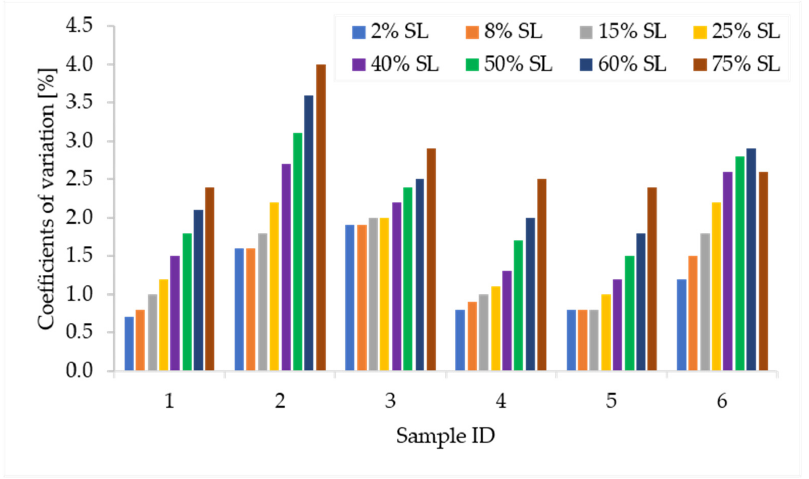
Figure 4. Coefficients of variation of fibrogram length values among tests at each percent span length during the short-term study. An increase in CV% from the longer span lengths (lower percentages) to the shorter span lengths (higher percentages) could be due to a decrease in the signal-to-noise ratio of the sensor. The greatest occlusion of light occurs at the base of the beard, which means very little light, i.e., signal, reaches the sensors, thereby allowing electrical noise to have a greater influence on the output. As it was reported, the length measurement variations of the fibrogram at each span length for the short-term period is small (i.e., CV% below 5%) and acceptable. As explained earlier, some variation in fiber properties is expected be- cause of the inherent nature of cotton (indeterminate growth, growing conditions, har- vesting, ginning, etc.). 3.1.3. Long-Term Visual and Trends Assessment The long-term stability assessment has 15 observations distributed over a period of eight weeks. The stability of the length measurements at each percent span length for each sample over this period was evaluated. The average fiber length measurement of 10 rep- lications for a given percentage of fibers (% span length) was computed and plotted against time. In the same way, the scatter plots of length measurements at each span length for each sample for the middle portion of a fibrogram for all samples are shown in Figure 5 as an example to visualize potential long-term trends.